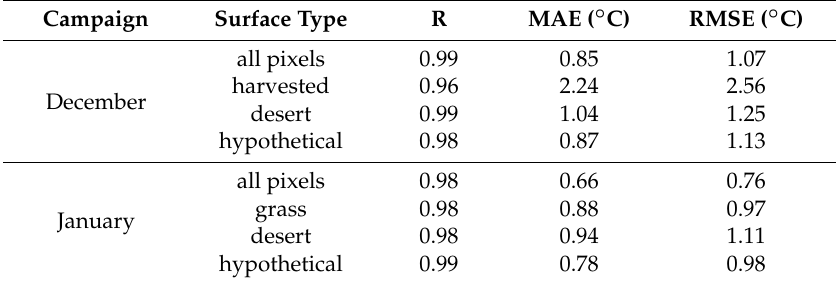
Figure 10. Diurnal Meteosat Second Generation (MSG)-based LST, UAV-based LST for all observed pixels (with error bars corresponding to standard deviation), UAV-based LST for desert pixels only, UAV-based LST for pivot pixels only, and hypothetical LST during ( a ) the December and ( b ) the January campaigns. Table 4. An intercomparison between UAV-based and MSG-Spinning Enhanced Visible and Infrared Imager (SEVIRI) based LST for all pixels, desert pixels only, vegetation pixels only, and a hypothetical LST. R is the correlation coefficient, MAE is the mean bias and RMSE is the root mean square